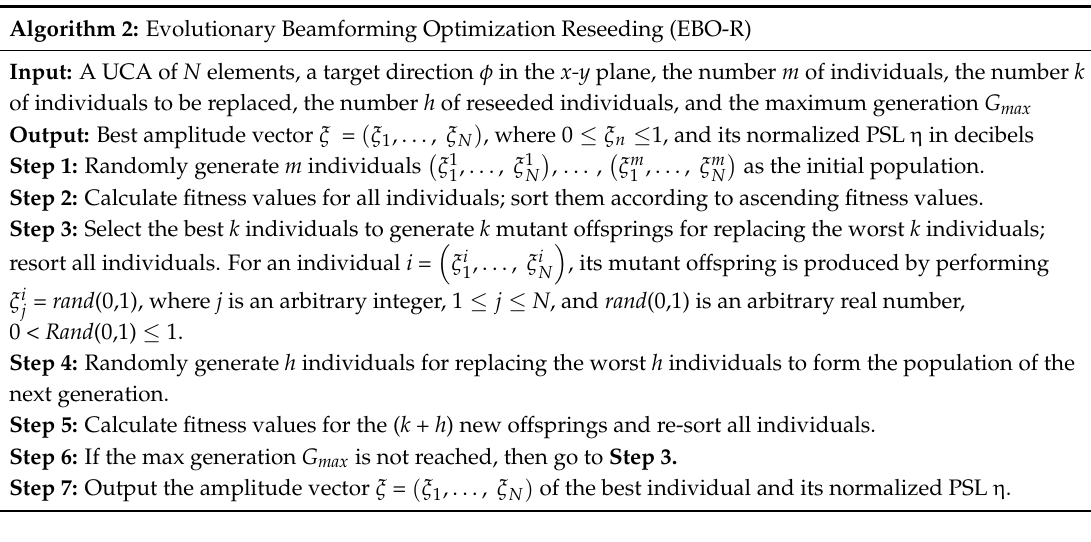
Algorithm 2: Evolutionary Beamforming Optimization Reseeding